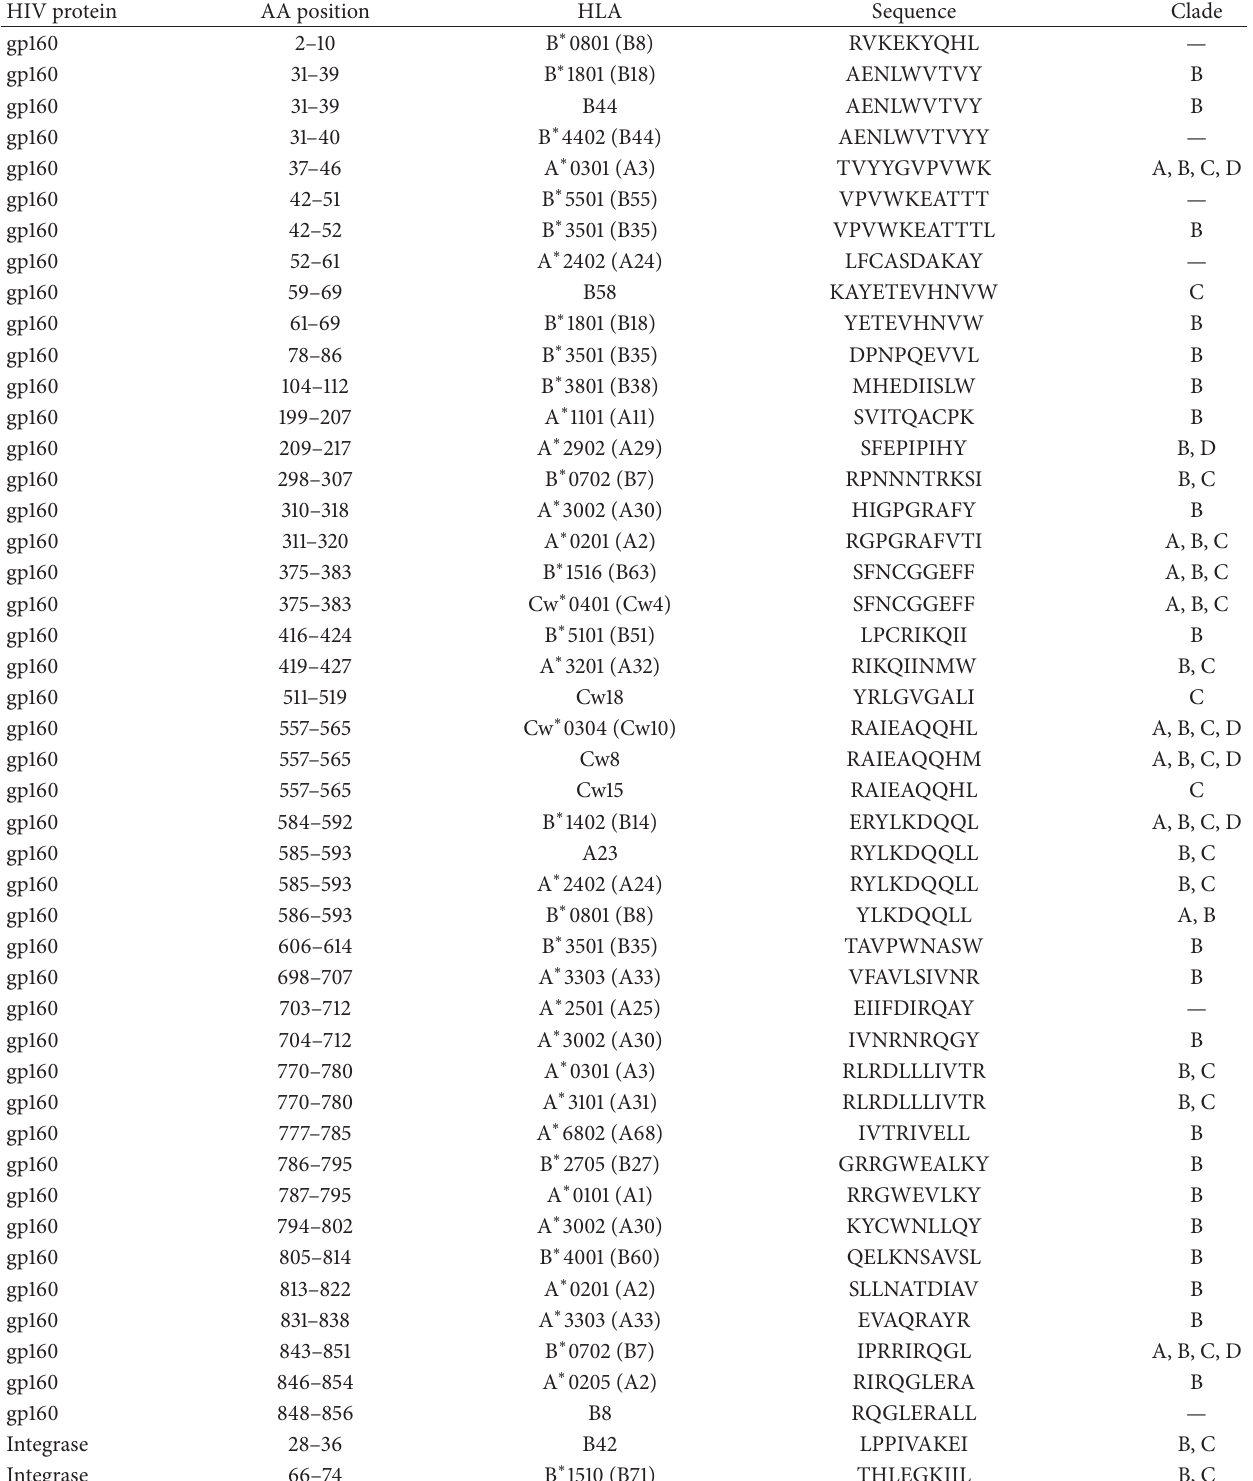
Table 2: List of optimal CTL epitopes for HIV-1 (taken and modified from HIV molecular immunology database (http://www.hiv.lanl.gov/content/immunology/tables/optimal ctl